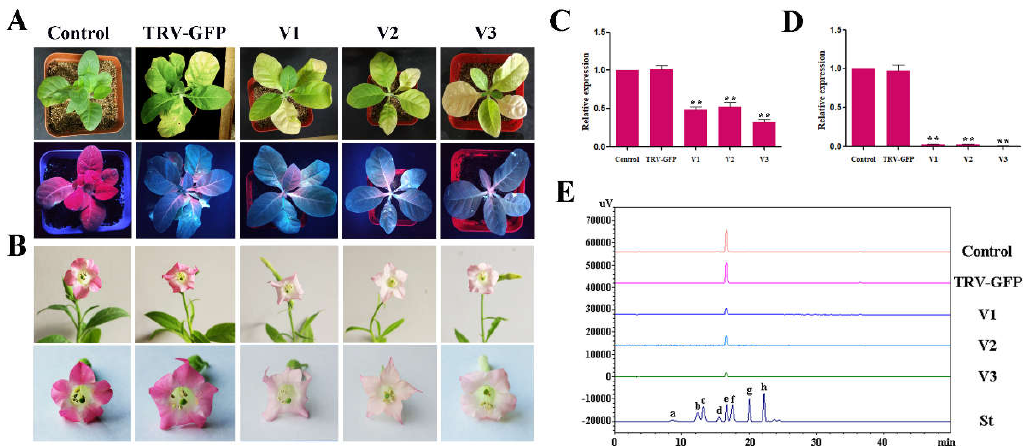
Figure 10. Analysis of OE- RrGT2 tobacco plants treated with VIGS. ( A ) Comparisons between the control group and the VIGS-treated groups (TRV-GFP and TRV-GFP- RrGT2 ) with respect to leaves at 14 days after infection. The plants were imaged under normal light and ultraviolet illumination. V1, VIGS- RrGT2 -1; V2, VIGS- RrGT2 -2; V3, VIGS- RrGT2 -3. ( B ) Phenotypic comparison of the flowers between the OE- RrGT2 -VIGS tobacco group and the control group and empty vector group. qRT-PCR detection in the leaves ( C ) and flowers ( D ) of the control and VIGS-treated groups. The error bars represent the SDs of triplicate reactions. The experiment was repeated three times and each yielded similar results. ** indicates a significant difference from the control at p < 0.01 according to Student’s t -test. ( E ) HPLC-derived chromatograms of the flowers in the control group and VIGS-treated groups. Eight kinds of anthocyanin standards (St) were used for detection: (a) Dp3G5G; (b) Cy3G5G; (c) Dp3G; (d) Pg3G5G; (e) Cy3G; (f) Pn3G5G; (g) Pg3G; and (h) Pn3G.